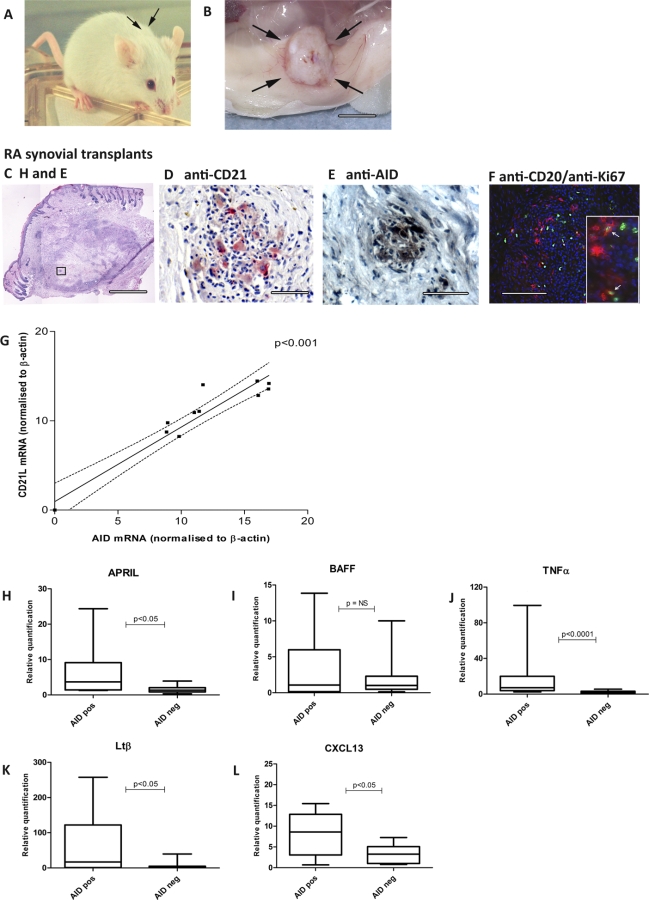
Rheumatoid Synovial Grafts in SCID Mice Maintain AID Expression and the Up-regulation of Genes Determining Lymphoneogenesis(A) Rheumatoid synovial tissue (n = 56) was transplanted into SCID mice (arrows depict site of transplants).(B) Transplanted RA synovial tissue in SCID mouse.(C–F) Montage image of a paraffin embedded haematoxylin and eosin stained section of transplanted tissue depicting the whole graft (original magnification 4×, area outlined in black equates to aggregate seen at higher magnification in [D] and [E]). Sequential sections of transplants stained using conventional immunohistochemistry for CD21 (D), AID (E), and double immunofluorescence for Ki67 (green) and CD20 (red) (F) (inset at 40× magnification, with arrowheads indicating the cells staining positively for Ki67 and CD20) demonstrated persistent FDCs, associated expression of AID (original magnification 40×) and continued proliferation of B cells. Four weeks post-transplantation, total RNA from the grafts was reverse transcribed and used for QT-PCR to determine the mRNA expression levels of AID and CD21L and a number of genes known to correlate with lymphoid tissue organization.(G) A significant correlation between levels of transcripts for AID and CD21L was found and AID was detected only in the presence of CD21L.(H–L) Tissues were stratified according to the presence or absence of AID as determined by QT-PCR, and analysed for the expression of the selected cytokines/chemokines genes between the groups. A significant difference is seen in levels of APRIL (H), CXCL13 (L), TNFα (J), and LTβ (K). Significant p-values are depicted, Mann-Whitney U test. No significant difference is seen between levels of BAFF (I). The lower and upper margins of the box represent the 25th and 75th percentiles, with the extended arms representing the 10th and 90th percentiles, respectively. The median is shown as a horizontal line within the box. Scale bars: 6 mm (B) 2 mm (C), 50 μm (D, E, F).